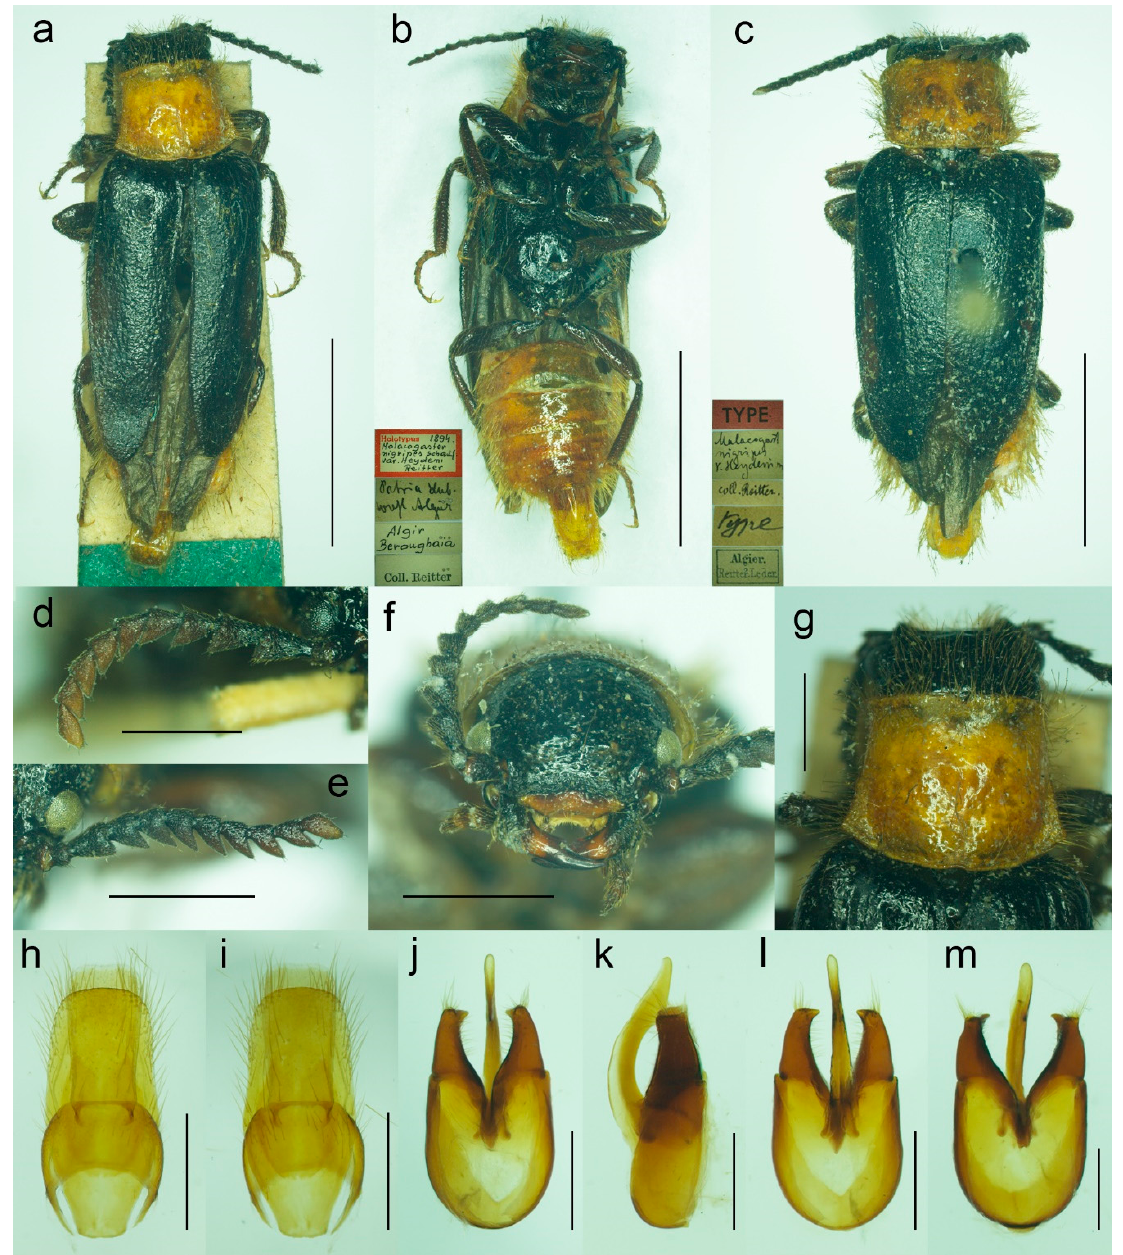
Figure 13. Malacogaster nigripes Schaufuss, 1867. Lectotype and paralectotype of of Malacogaster nigripes var. heydeni Reitter, 1894. ( a ) Lectotype habitus, dorsal view; ( b ) lectotype habitus, lateral view; ( c ) paralectotype habitus, dorsal view; ( d ) lectotype right antenna; ( e ) paralectotype left antenna; ( f ) paralectotype head, frontal view; ( g ) lectotype pronotum, dorsal view; ( h ) lectotype genital capsule formed by tergites IX and X, and sternite IX, dorsal view; ( i ) lectotype genital capsule formed by tergites IX and X, and sternite IX, ventral view; ( j ) lectotype aedeagus, dorsal view; ( k ) lectotype aedeagus, lateral view; ( l ) lectotype aedeagus, ventral view; ( m ) paralectotype aedeagus, dorsal view. Scale bars = ( a – c ) 4.0 mm; ( d , g – i ) 1.0 mm; ( e , f ) 1.5 mm; ( j – m ) 0.5 mm.